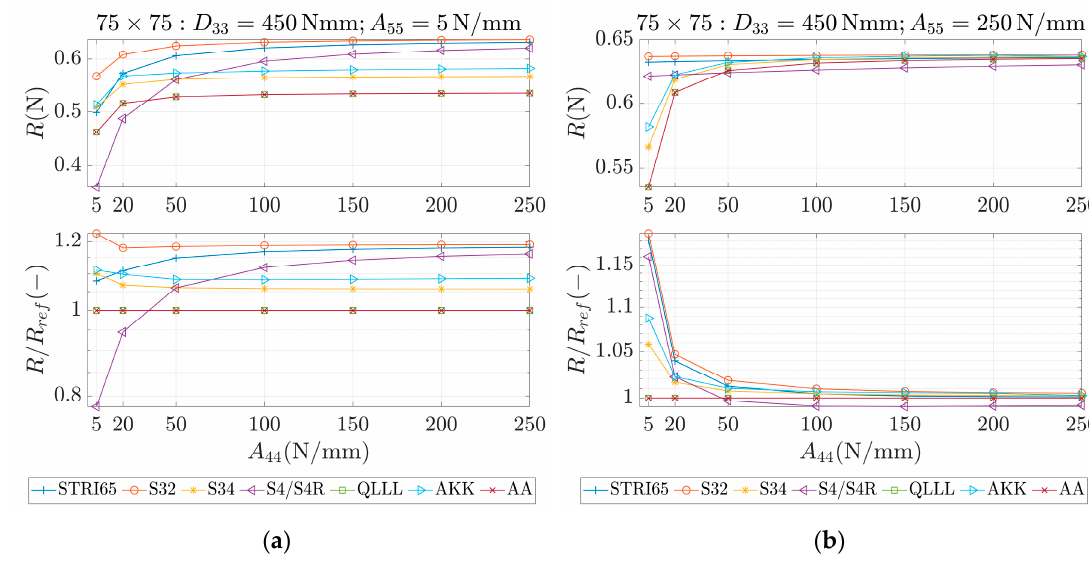
Figure 7. Reactions (first row) and reactions to the reference (analytical) solution (second row) for 75 × 75 sample, D 33 = 450 Nmm and di ff erent values of A 44 . ( a ) A 55 = 5 N / mm and ( b ) A 55 = 250 N/mm.